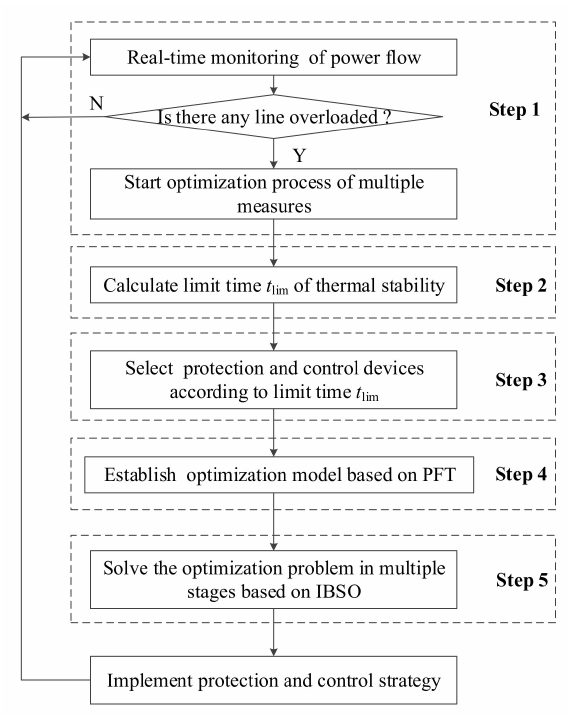
Figure 5. Flow chart of the optimization